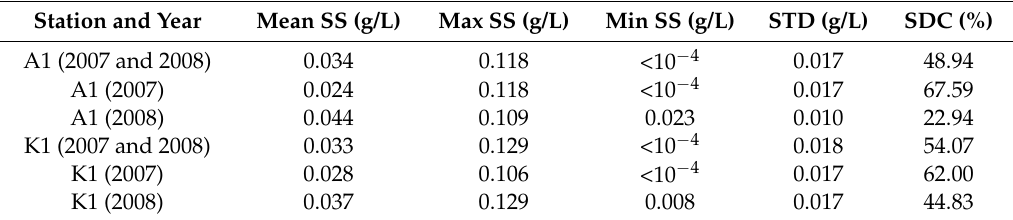
Table 1. Summary statistics for the suspended sediment (SS) data at stations A1 and K1 in 2007 and 2008. STD, standard deviation; SDC, standard deviation